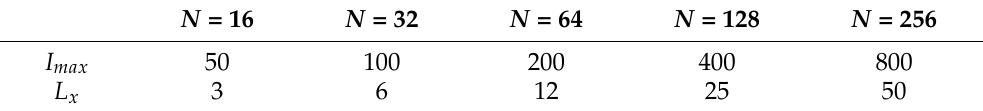
Table 1. Power limit settings: I max —the maximal line current (in Amperes) of the whole farm, L x —the maximal number of EVs charging in one time slot given a constant charging rate of 16